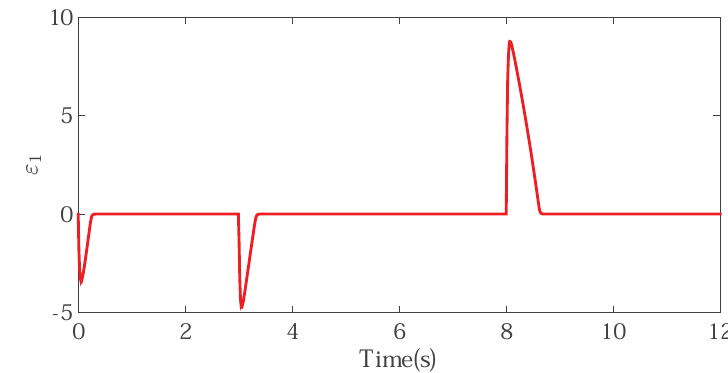
Figure 8. The filter compensating signal.